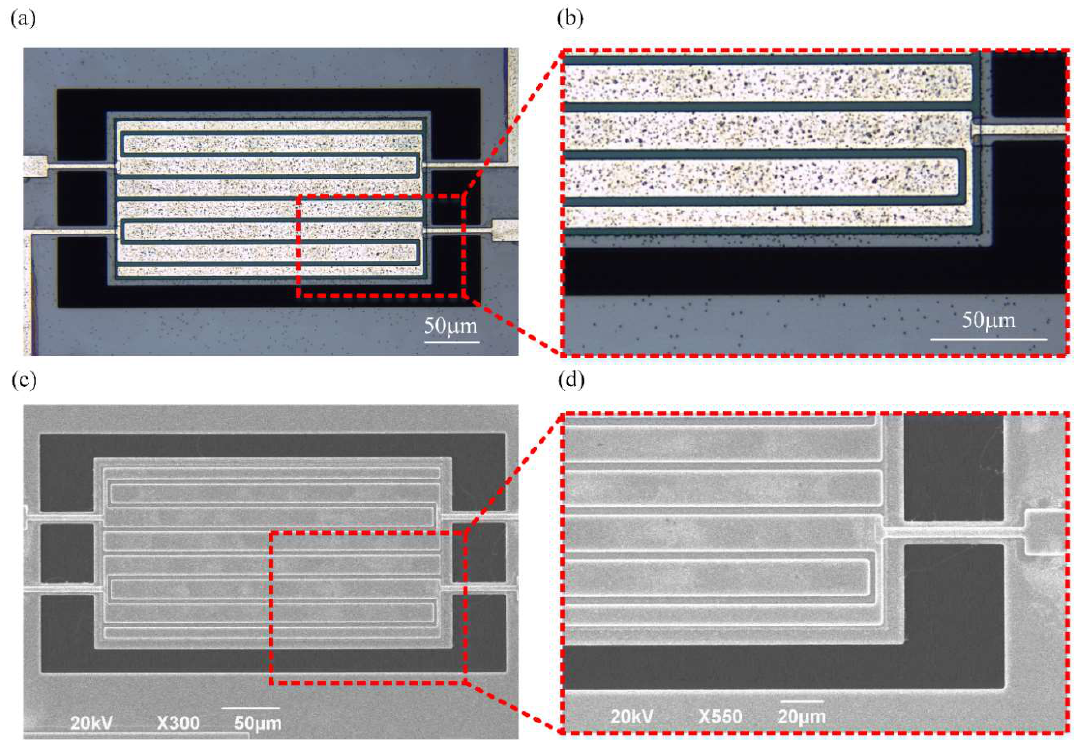
Figure 6. ( a ) The resonator with the DIDO configuration was fabricated using the MEMSCAP piezo micromachining process for the investigation of the effects of the DIDO configuration. High-magnification microscope images of ( b ) resonator with DIDO configuration exhibit the details of the resonator and also the interdigital electrodes. ( c , d ) shows the scanning electron micrographs of the resonator.